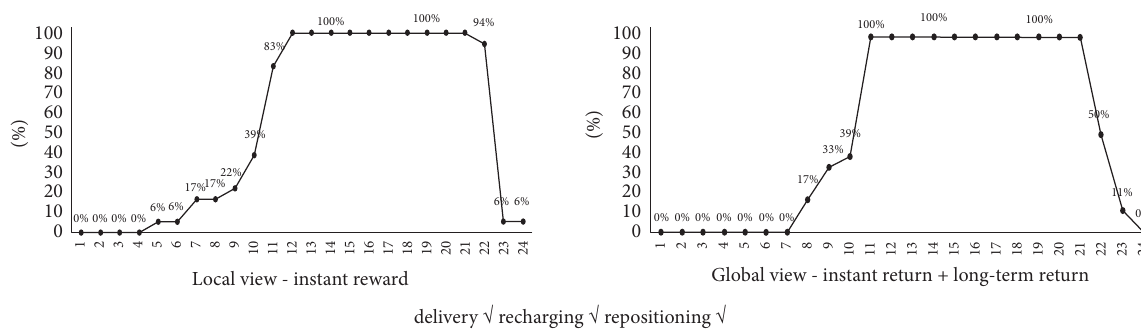
Figure 15: Pile utilization rate comparison of global view and local